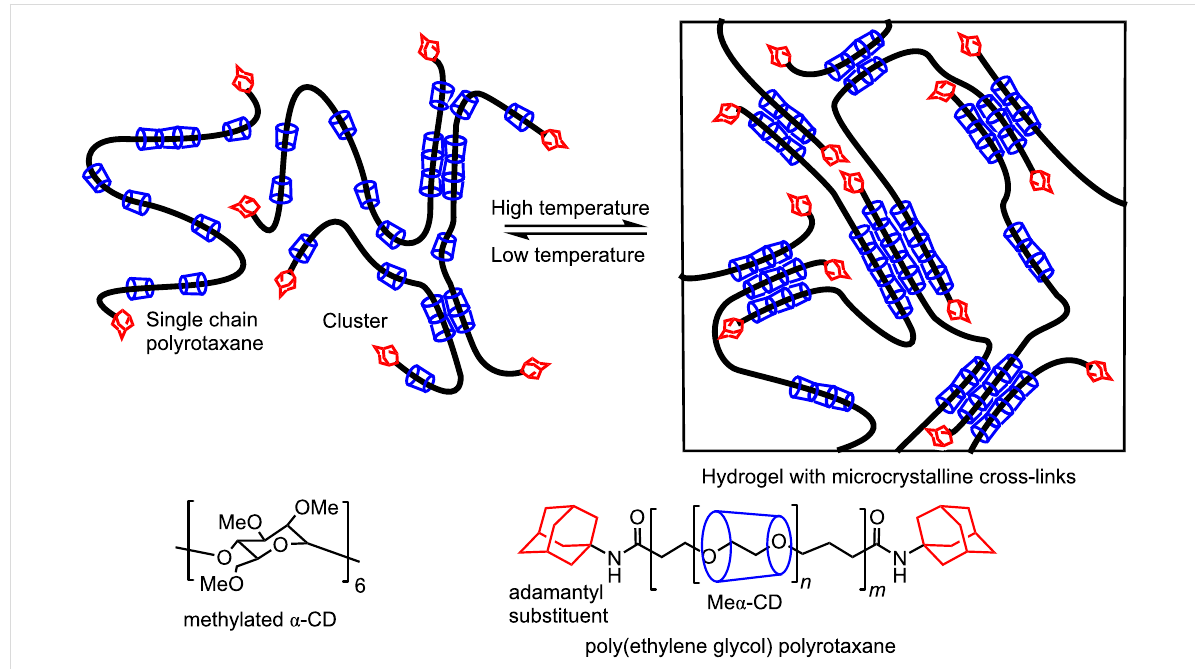
Figure 17: Structure of poly(ethylene glycol) polyrotaxane with adamantyl end substituents, and its temperature dependent equilibrium between the solution and hydrogel states